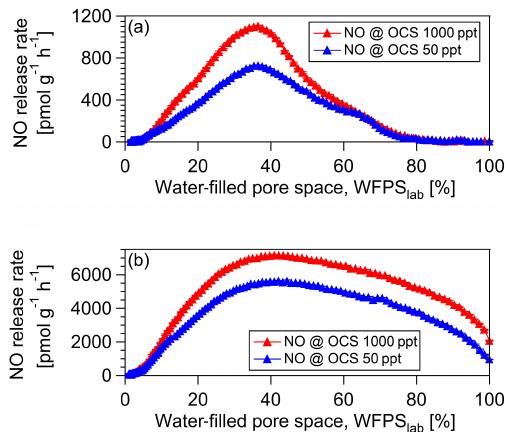
Figure 5. NO exchange rates (a) are shown for a midlatitude corn- field soil sample 40 ◦ C dried from Mainz, Germany (A1), and a soil sample originated from a spruce forest in Sparneck, Germany, at OCS mixing ratio of 50ppt (blue) and 1000ppt